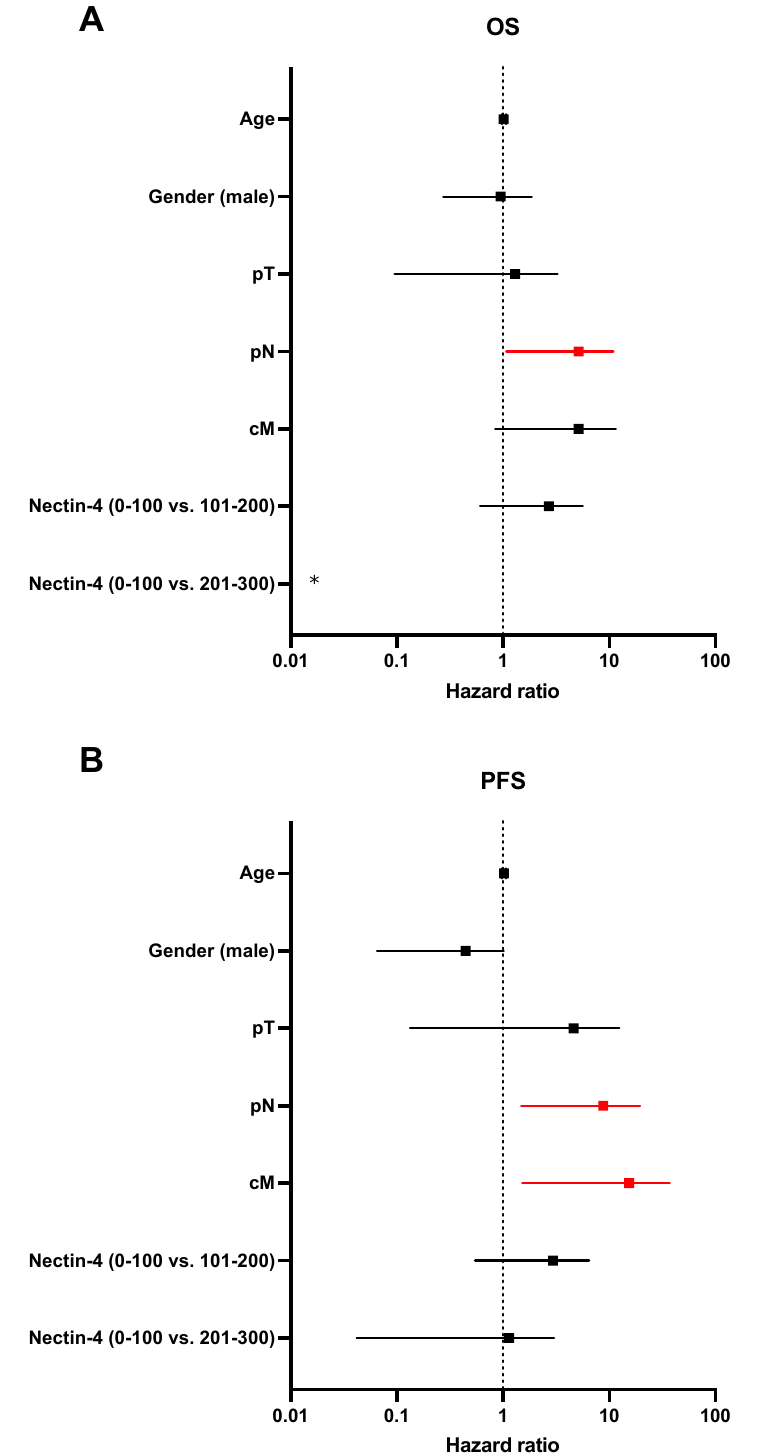
Figure 4. Multivariate analysis for OS and PFS in SCC. Age, gender, T-stage (pT), nodal stage (pN), radiological detected metastases (cM), and Nectin-4 expression were used as variables and independent prognostic potential evaluated for OS ( A ) and PFS ( B ). p values less than 0.05 were considered as statistically significant and groups are marked in red. * Data are outside of the axis limit due to sample size (HR: 0, 95% CI 1.221E − 188 to 1.182E + 177).